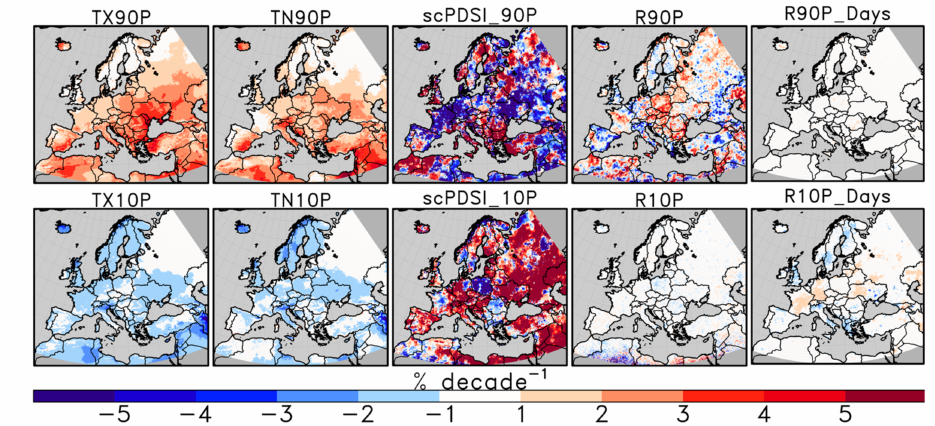
Figure 4. Spatial distribution of the trends in the extreme